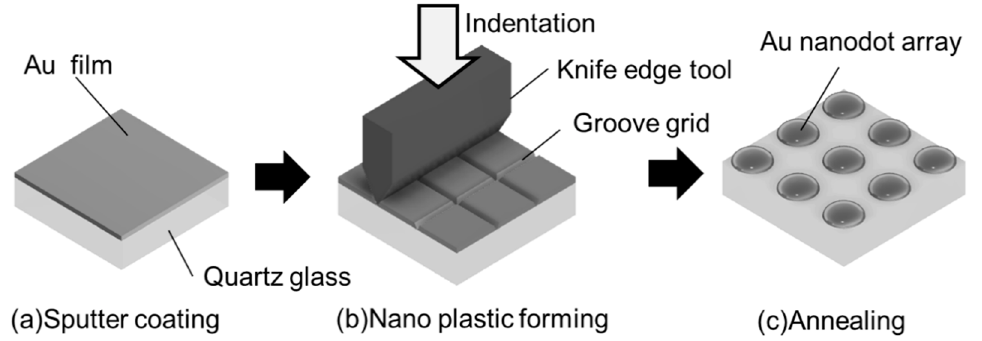
Figure 1. Schematic illustration of proposed fabrication process.